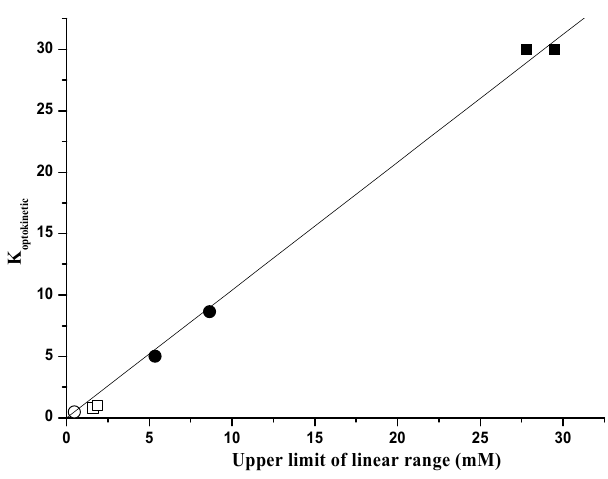
Figure 7. Optokinetic parameter K as a function of the extent of the linear range. Fluorescence emission of free GOD in visible range( (cid:129) ), in UV range ( (cid:70) ). Fluorescence emission of immobilized GOD in visible range ( (cid:81) ), in UV range ( (cid:74) ). Empty and full dots refer to results in reference